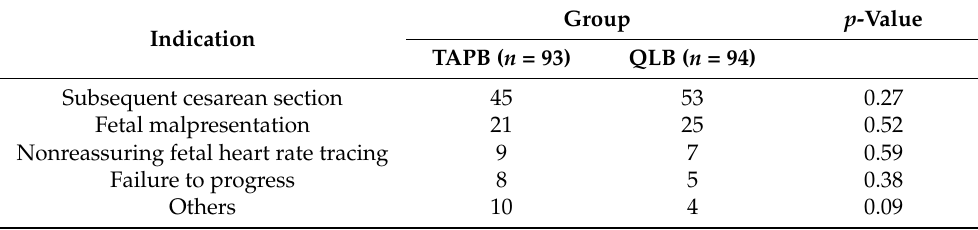
Table 2. Indications for cesarean